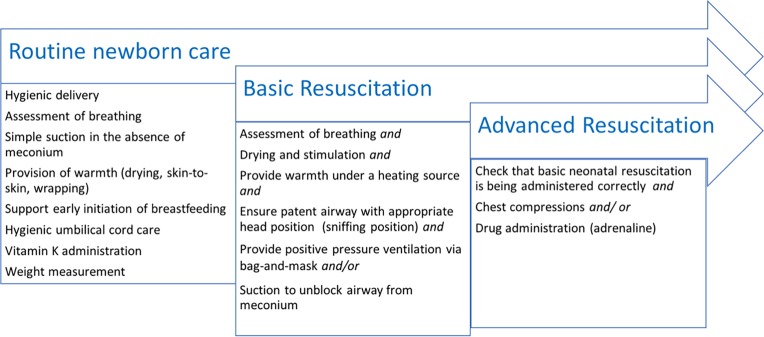
Definitions of different levels of newborn assistance at birth in SMRU.